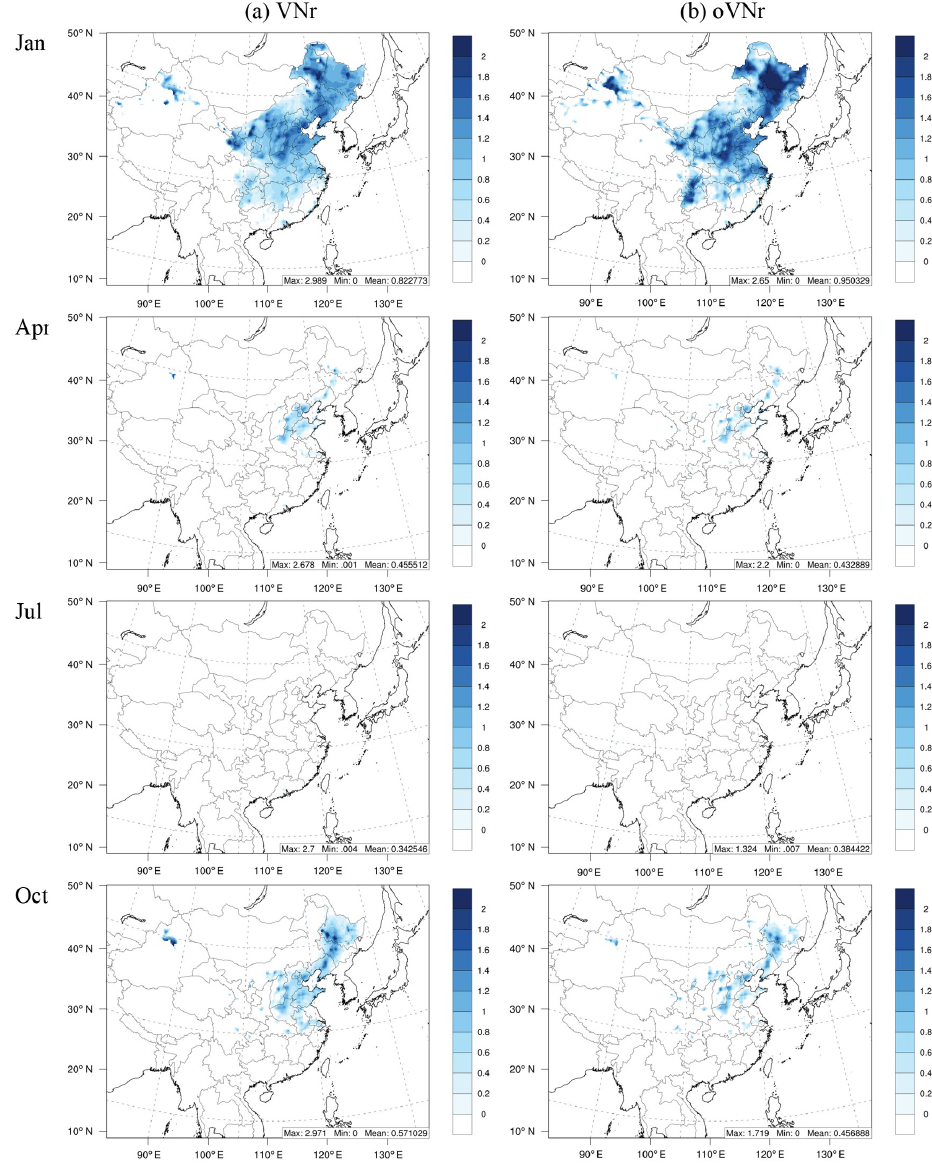
Figure 10. Comparison of VNr with